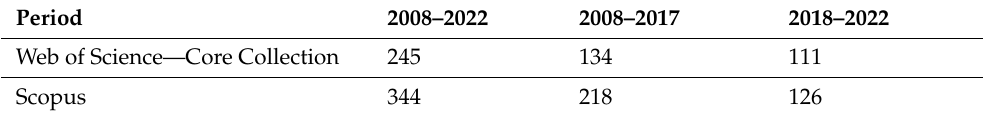
Table 1. Number of articles published on “green jobs”.